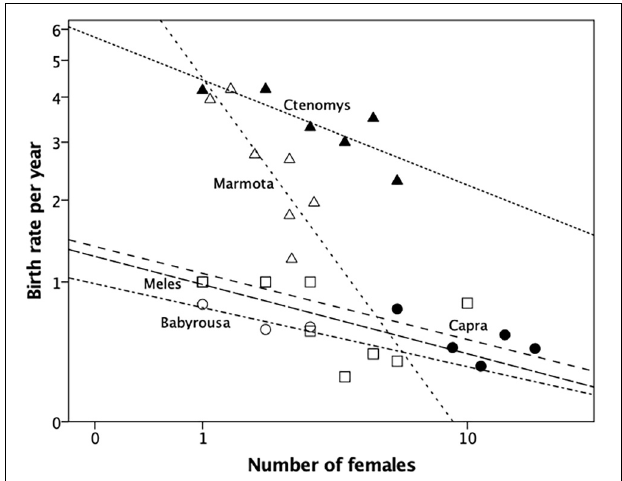
FIGURE 2 | Mean fecundity (litters per female per year) for groups of different size for a carnivore (European badger, Meles meles : squares), two rodents (tuco-tuco, Ctenomys sociabilis : filled triangles; yellow-bellied marmots, Marmota flaviventra : unfilled triangles) and two ungulates (babirusa, Babyrousa babyrussa : unfilled circles; feral goats, Capra hircus : filled circles). All datapoints are individual groups sampled from the same population. Sources: Downhower and Armitage (1971), Woodroffe and Macdonald (1995), Clayton and Macdonald (1999); goat data from RIMD. Source: Supplementary Dataset 2